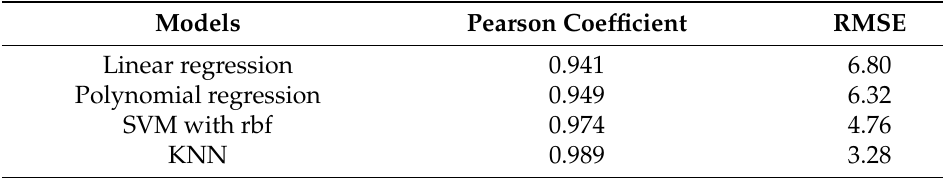
Table 2. Pearson coefficient and